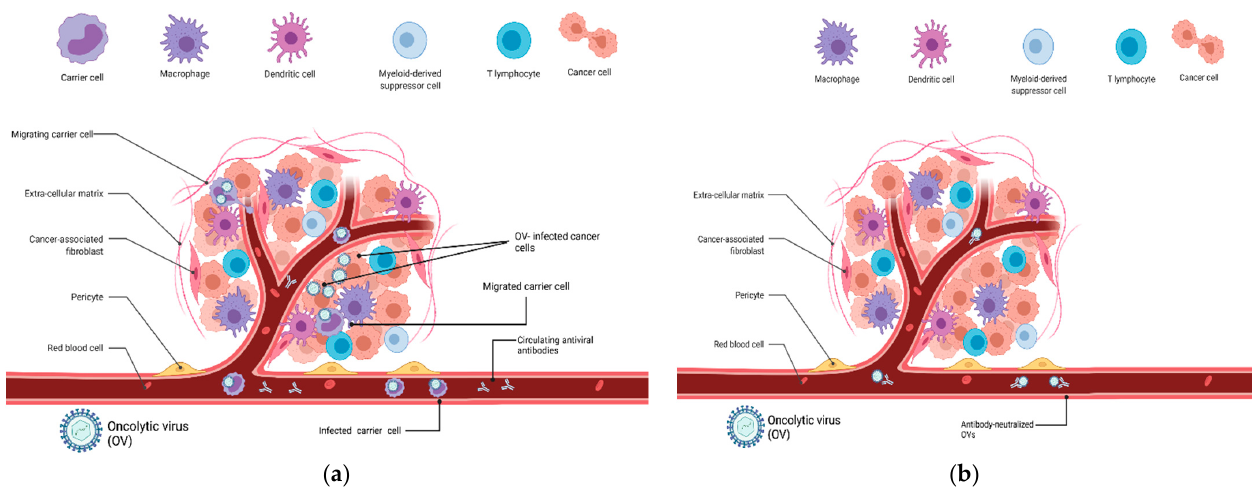
Figure 1. Bioavailability of an oncolytic virus to the tumor microenvironment following intravenous injection in the presence of pre-existing antibodies: ( a ) OV-infected carrier cells migrate into the TME, where they release viral particles, even in the presence of antiviral antibodies in the bloodstream; ( b ) cell-free virions in the bloodstream are neutralized by antibodies and cannot infect cancer